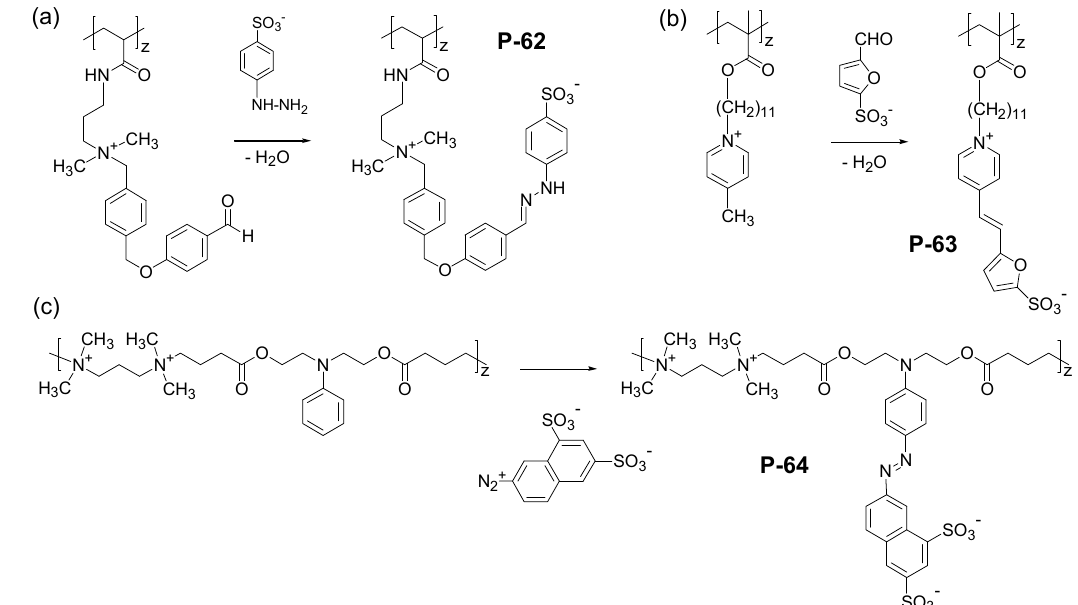
Figure 14. Zwitterionic polysaccharide made by coupling polycations to sulfonated reagents: ( a ) via hydrazone bonds [424]; ( b ) via aldol condensation [424,425]; ( c ) via azo coupling